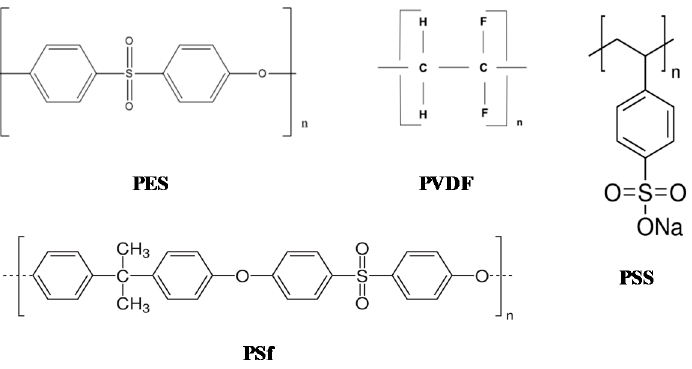
Figure 10. Polymers present in pristine HFM-183 membranes and their modifications, HFM-183+PSS and HFM-183+PSS+Ar. Table 4. Atomic percentages obtained by XPS.